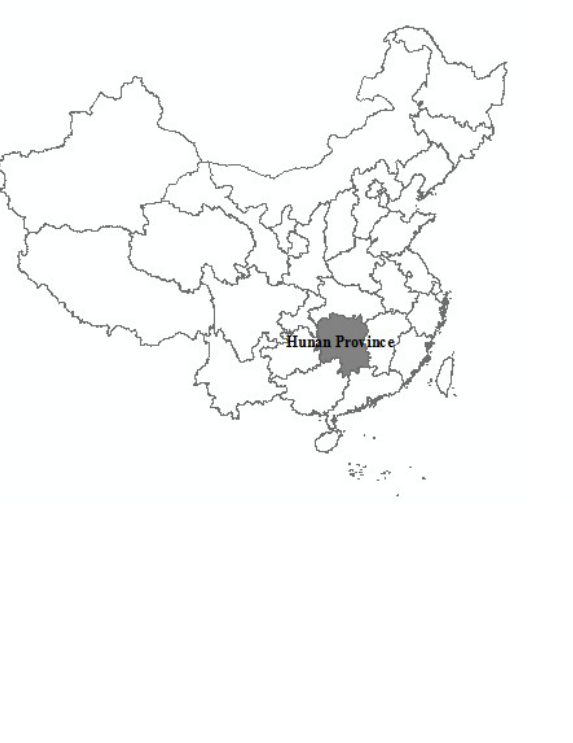
Figure 1. Geographical location of the study area. SX is Suxian District; HJ is Hongjiang